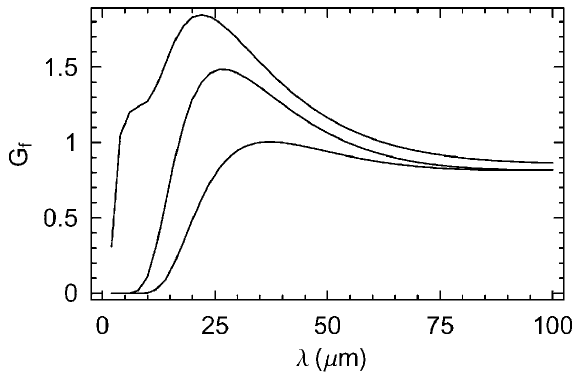
FIG. 1. Amplification factor G length (cid:6) of the perturbation at the compressor entrance for various beam emittance and energy spread: (1) (cid:7) 10 (cid:3) 5 , (cid:9) (cid:1) 1 (cid:10) m ; (2) (cid:7) 10 (cid:3) 6 , (cid:9) (cid:1) 1 (cid:10) m .